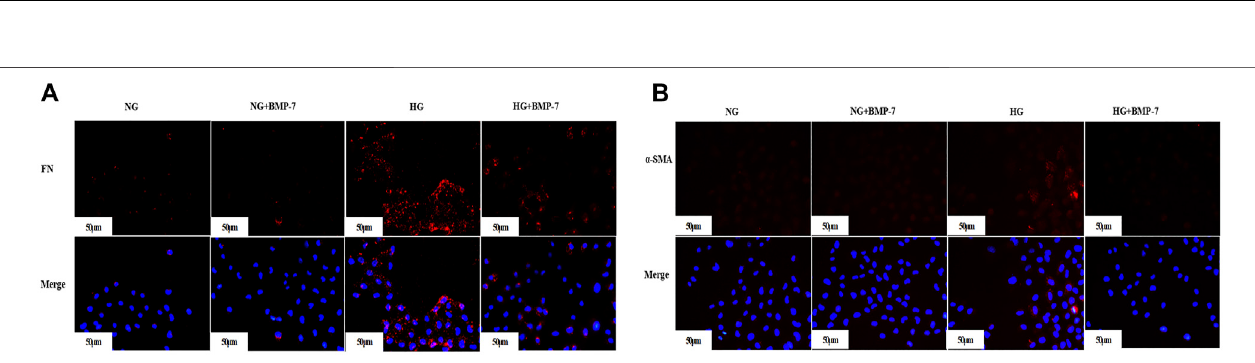
Frontiers in Pharmacology |